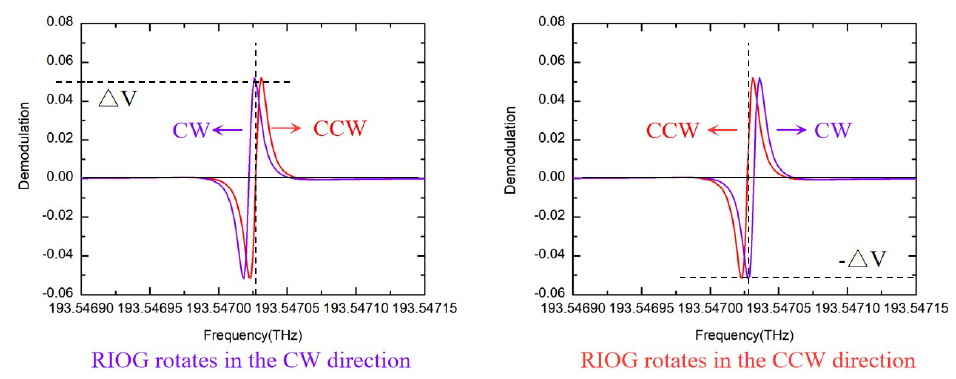
Figure 3. The principle of the rotational angular velocity signal detection.